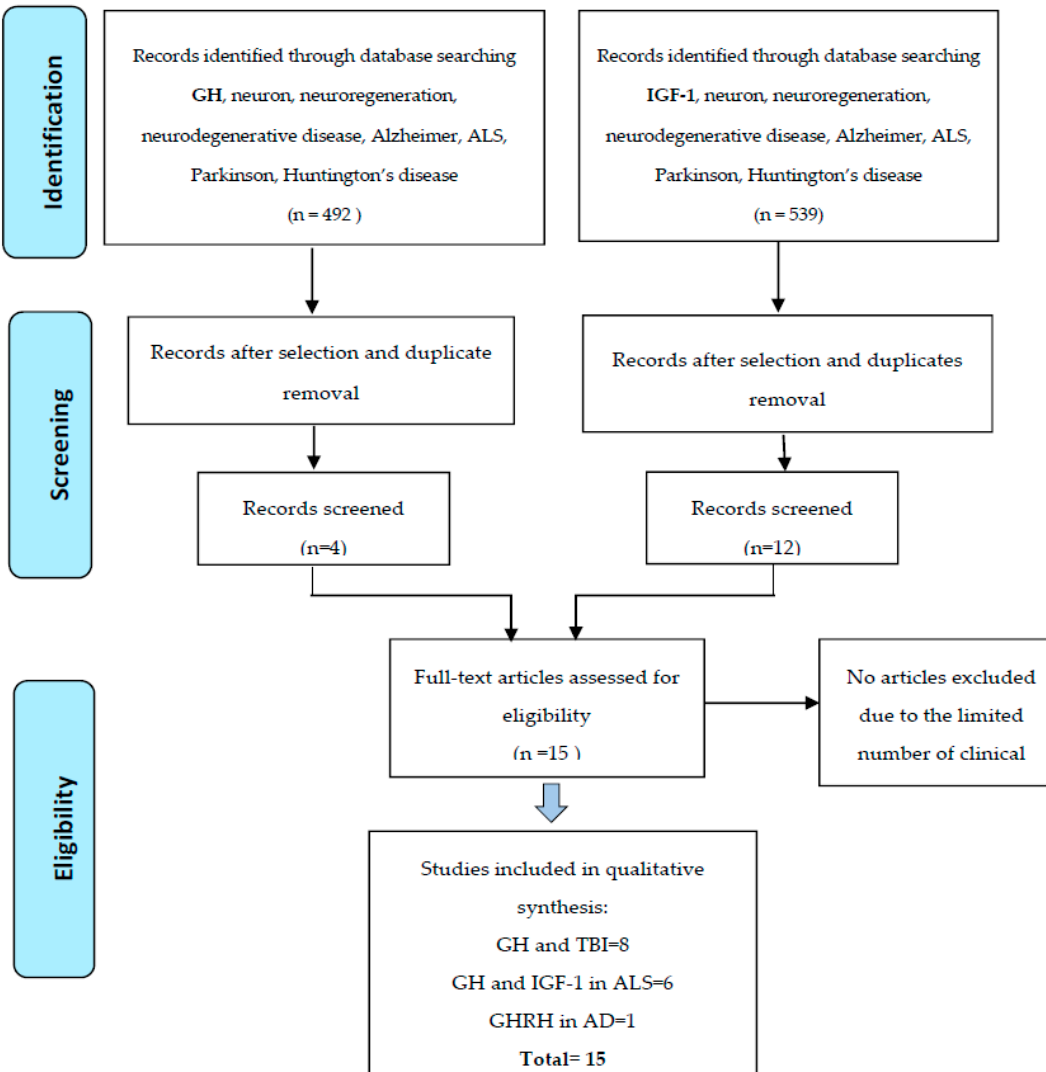
Figure 1. Flow chart illustrating the literature search and selection.